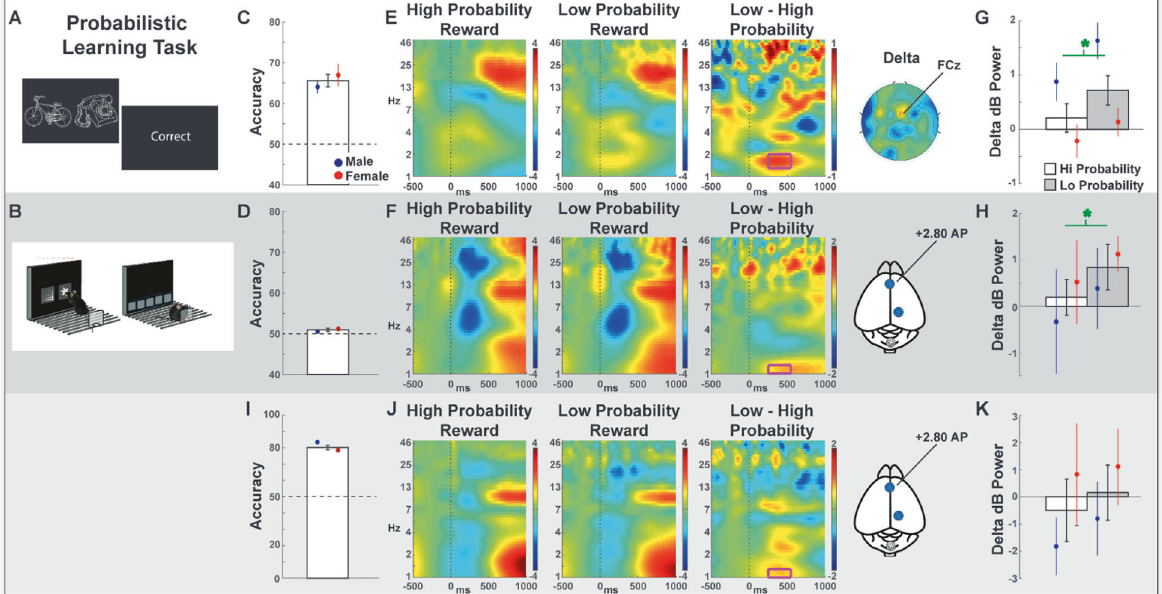
Fig. 3 The probabilistic learning task (PLT) required the subject to select the stimulus that probabilistically led to reward most often. A – B In humans and mice, each trial required a choice between two stimulus icons. C – D Total accuracies for each species, including means split by sex. E – F Time-frequency plots of high vs. low probability rewards at FCz in humans or the anterior lead in mice. The magenta box shows the delta-band tf-ROI. G – H EEG tf-ROI quanti fi cation of the difference in reward expectation conditions in frontal delta power. I – K Replication with a second cohort of mice on a simpler discrimination task. Bars are means (± SEM), green asterisks indicate statistically signi fi cant ( p < 0.05) within-subject